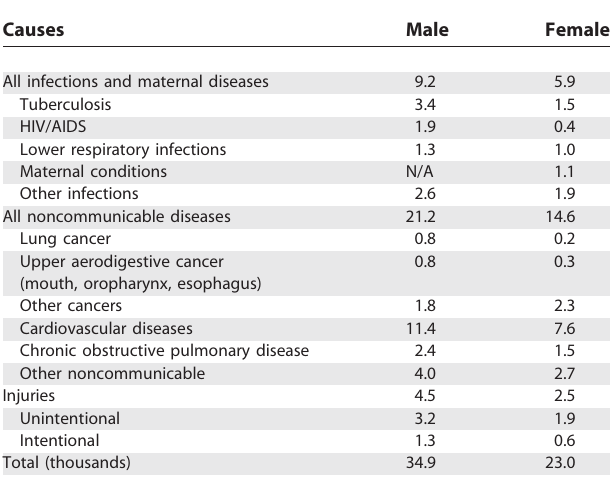
Table 1. Expected Number of Deaths between Ages 25 and 69 by Cause (Thousands), 2001 to 2003